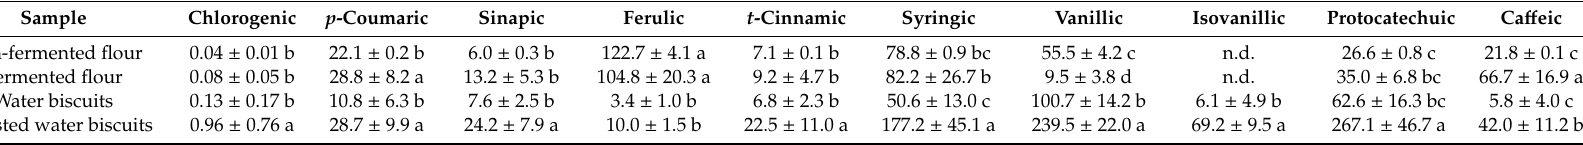
Table 3. Average levels of phenolic acids ( µ g / g) in non-fermented buckwheat flour, fermented flours, and water biscuits before and after in vitro digestion.